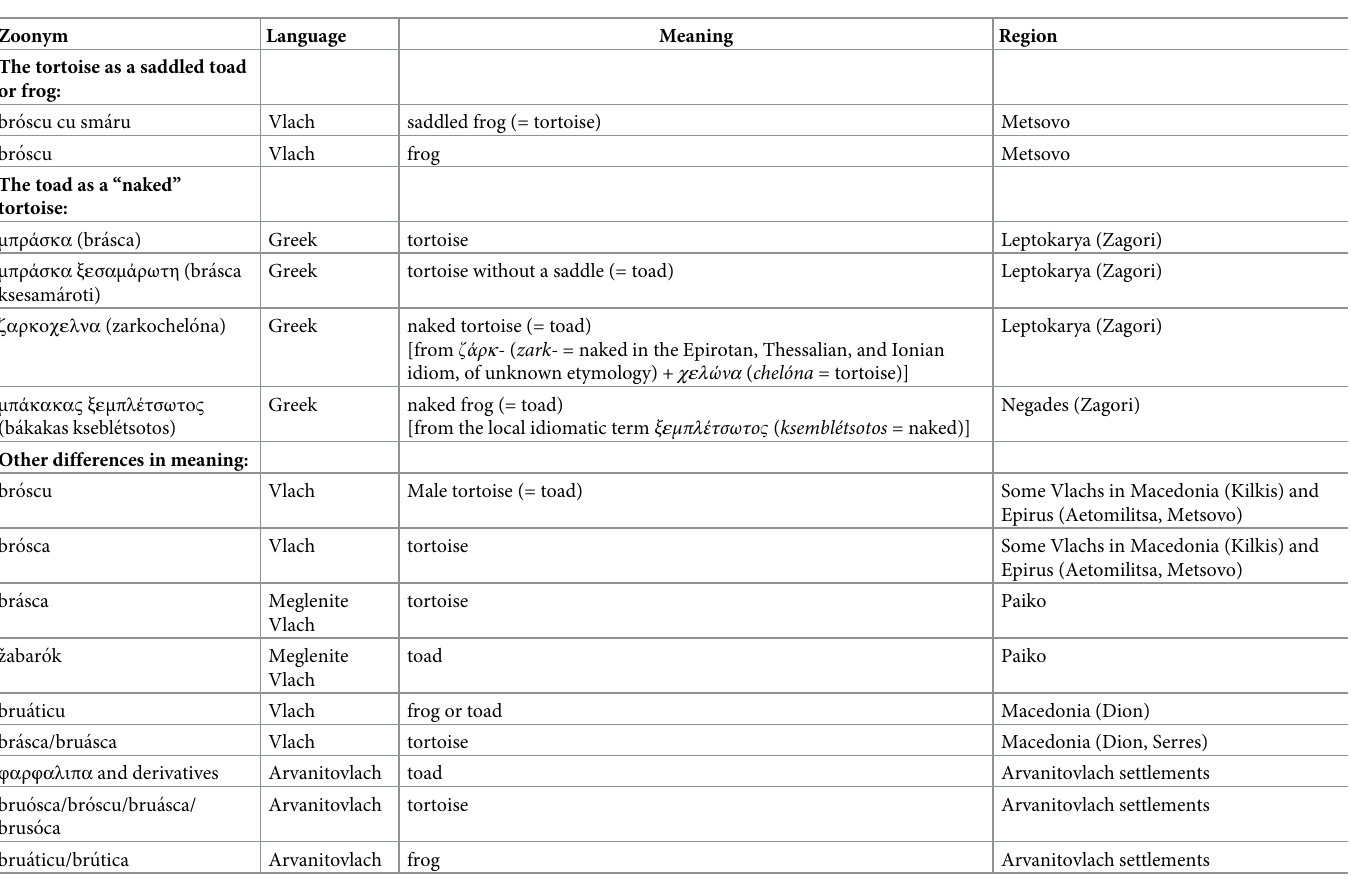
Table 1. Zoonym Language Meaning Region The tortoise as a saddled toad or